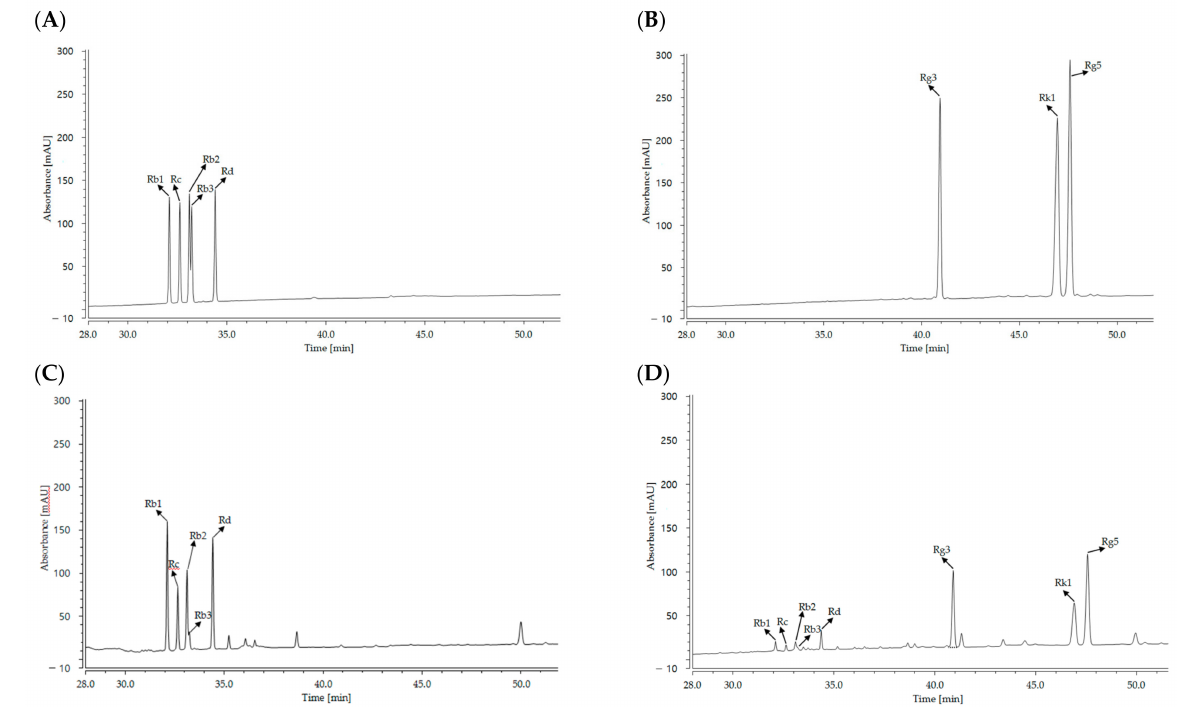
Figure 1. Representative HPLC chromatograms of ginsenosides detected incultured wild ginseng root and HLJG0701- β . ( A ) Ginsenosides Rb1, Rc, Rb2, Rb3, and Rd reference standards; ( B ) ginsenosides Rg3, Rk1, and Rg5 reference standards; ( C ) cultured wild ginseng root; ( D ) HLJG0701- β .